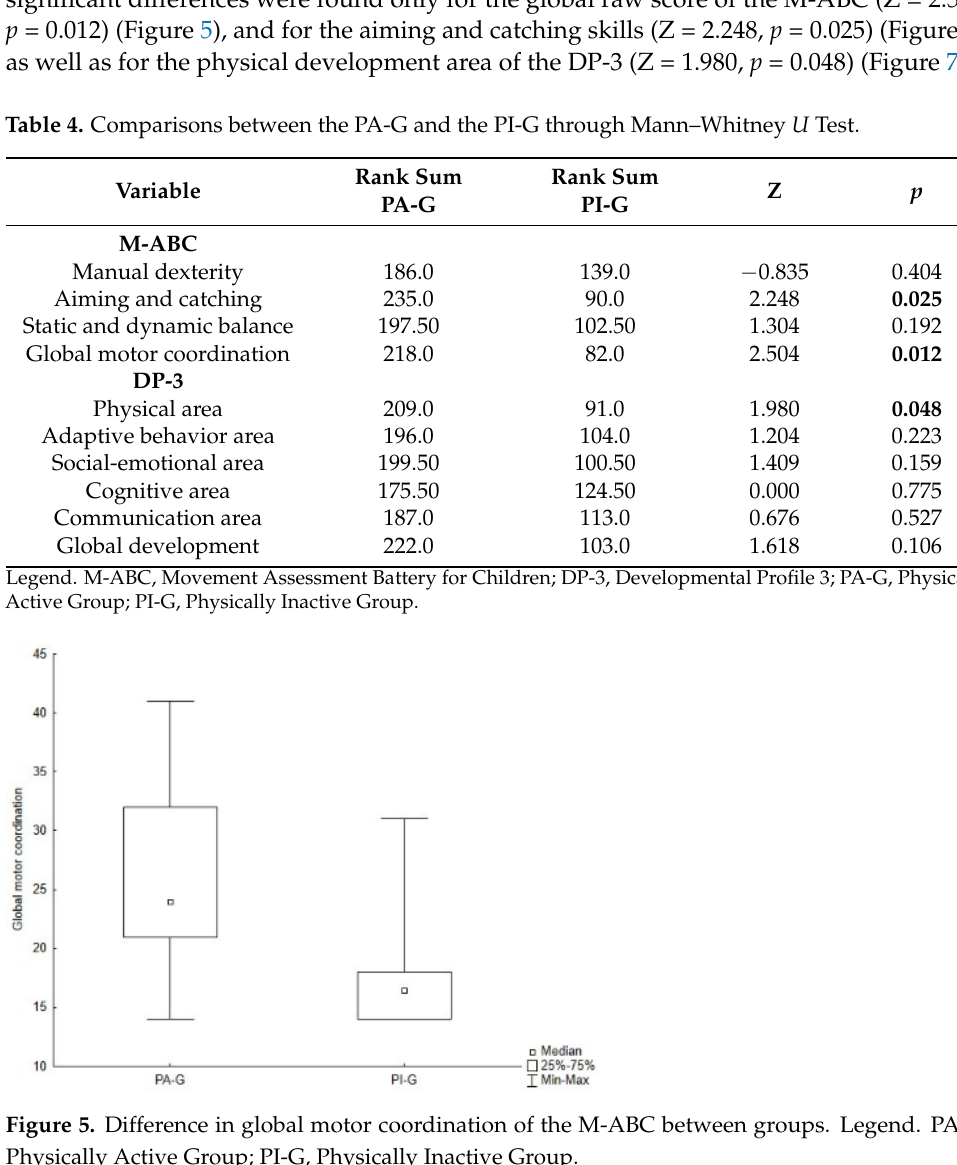
Figure 6. Difference in aiming and catching skills of the M-ABC between groups. Legend. PA-G, Physically Active Group; PI-G, Physically Inactive Group. Figure 7. Difference in physical development area of the DP-3 between groups. Legend. PA-G, Phys- ically Active Group; PI-G, Physically Inactive Group.